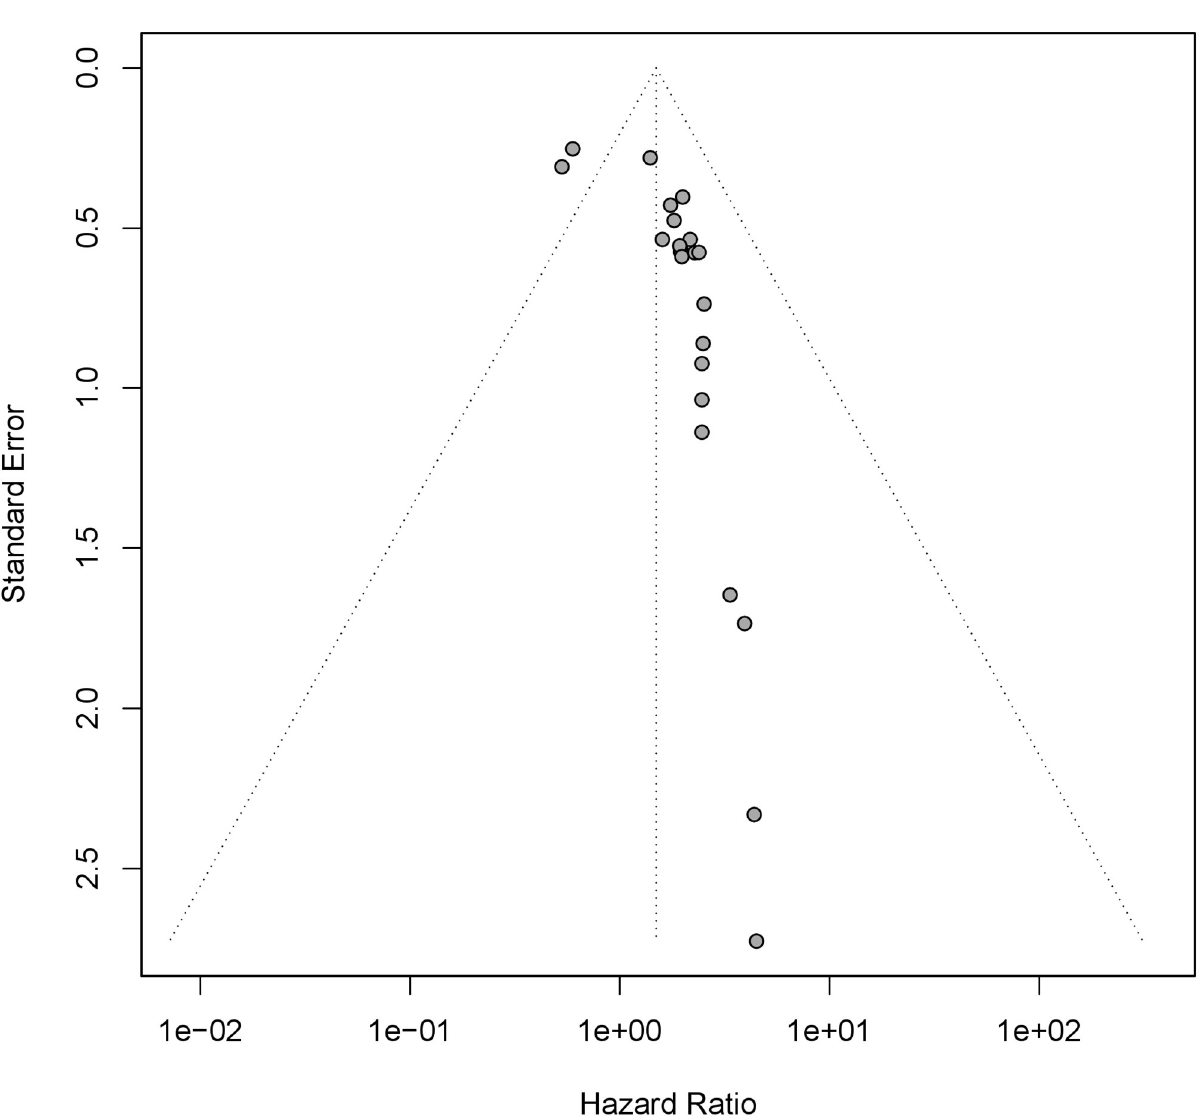
Fig 6. Funnel plot assess publication bias. The asymmetry on both sides of funnel plot suggested the existence of publication bias. Each point represents a separate study for the indicated